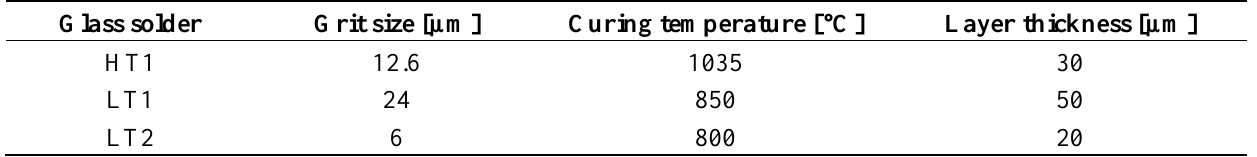
Table 1. Properties and parameters of the investigated glass solder coatings.